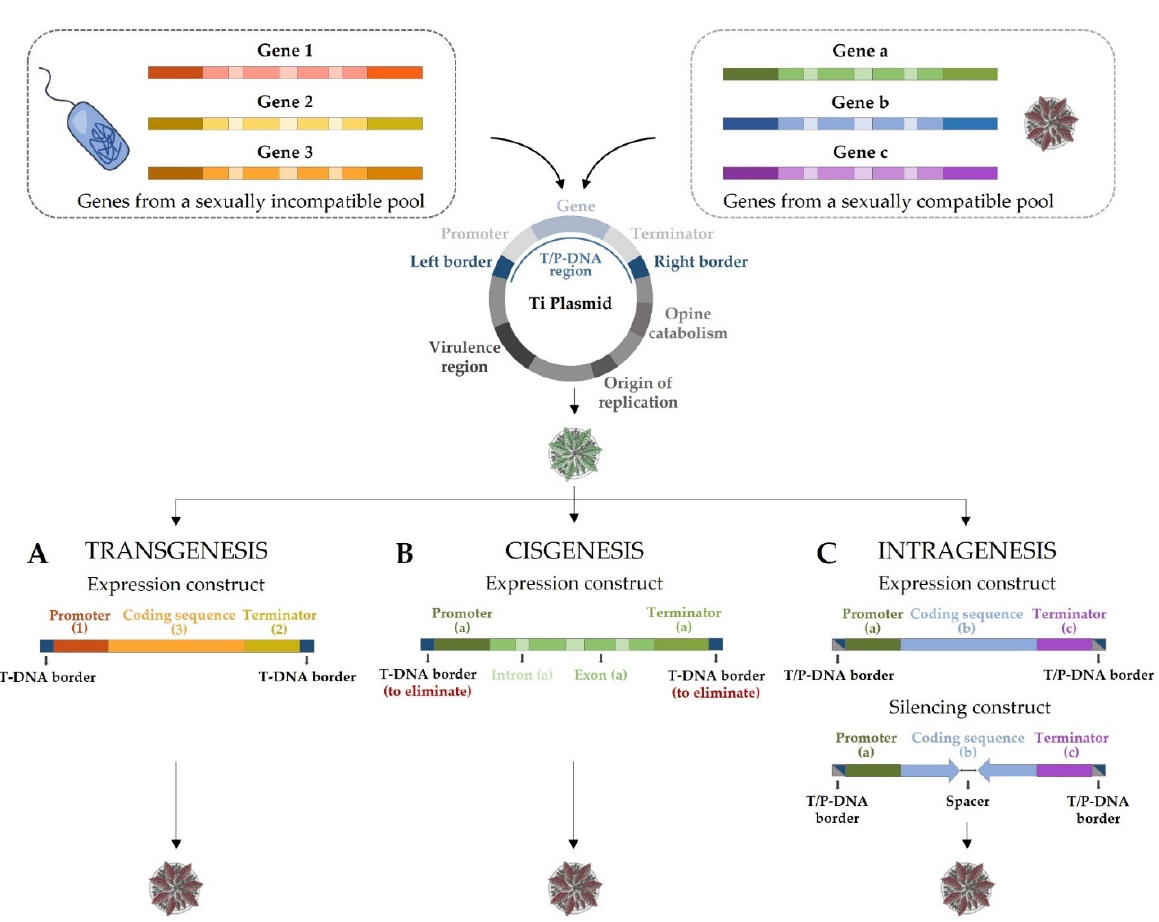
Figure 3. Schematic representation of three modern biotechnology techniques to introduce allelic variants of interest in a recipient organism: ( A ) transgeneis; ( B ) cisgenesis; and ( C )